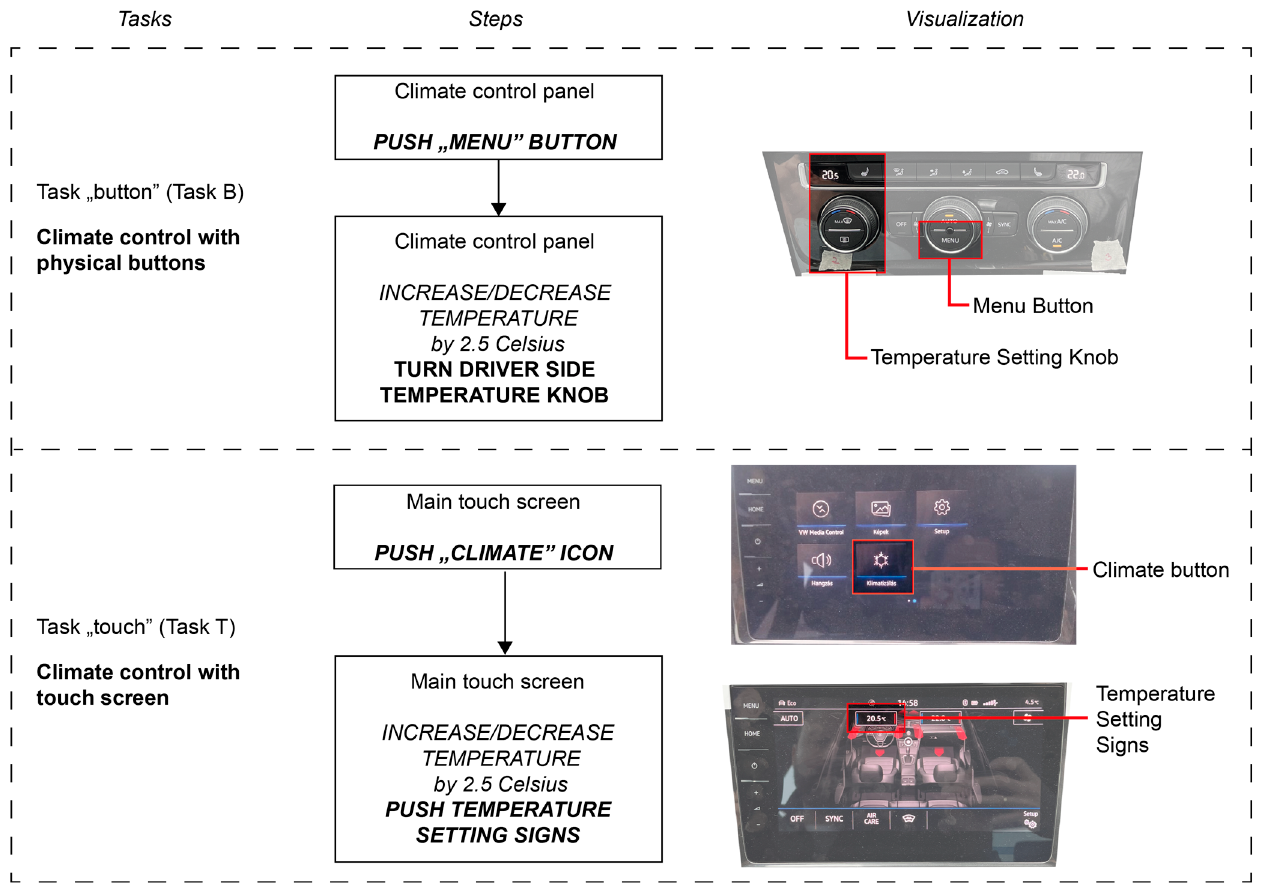
Figure 3. Task “button” (Task B) and Task “touch” (Task T) (with control panel icons and signs) performed at different speeds.